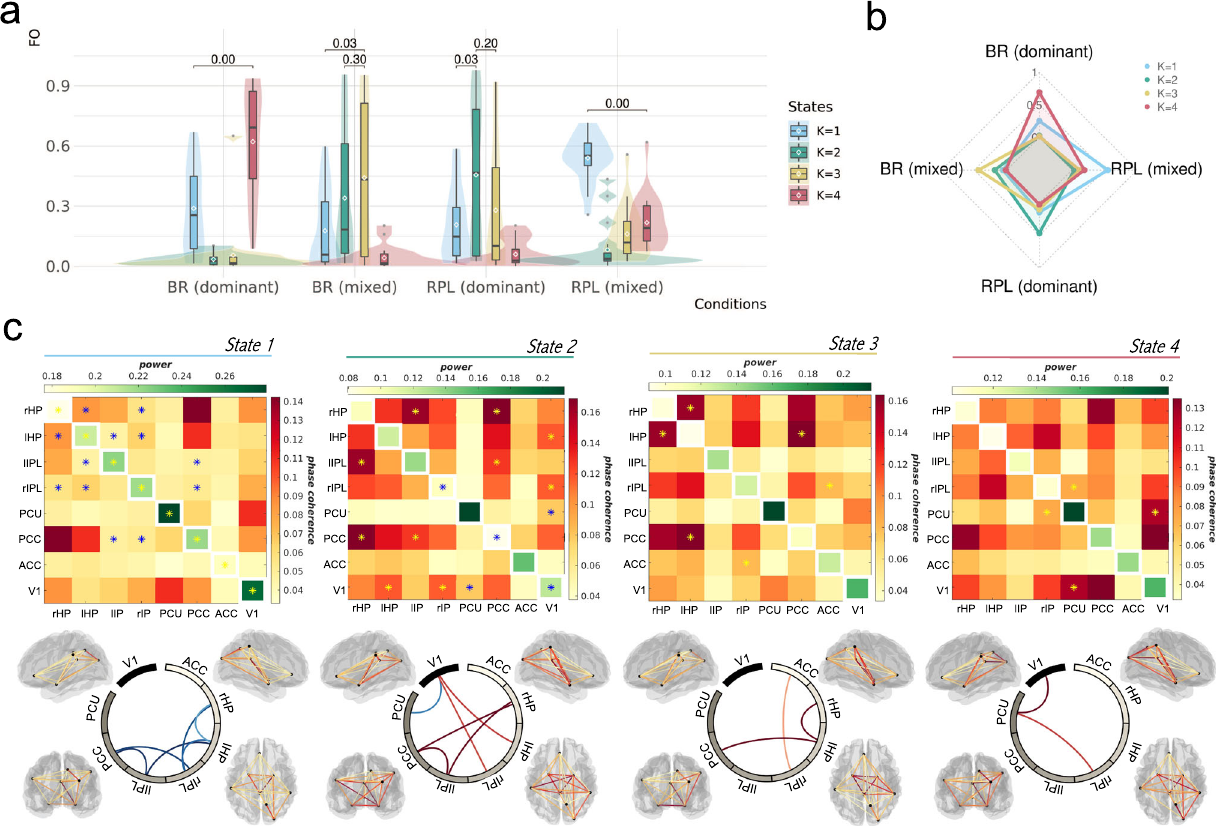
Fig. 5 | Correspondence between states and conditions. a Different fractional occupancy (FO) of the four states across conditions. Plotted data are the mean FO values averaged across trials for each individual, grouped by the two categorical variables: conditions and states. FDR-adjusted p -values of pairwise permutation tests (two-tailed) are presented on the signi fi cance bar on top of the compared groups ( N =20 per group). The distributions of non-averaged FO for all trials/ epochs of all participants, and an individual ’ s averaged State FO in the four experimentalconditionsarepresentedinSI(SupplementaryFigs.9and10).Forthe box plots, the white dot/circleon eachbox indicates the mean, while the length of the box indicatesquantileswith the middlebar showing the median. b Radarchart showing the correspondence between conditions and states. Scales on the radar chart indicate the median values of the state FO in the corresponding condition. c Spectral information of the states in the alpha band. Diagonal and off-diagonal